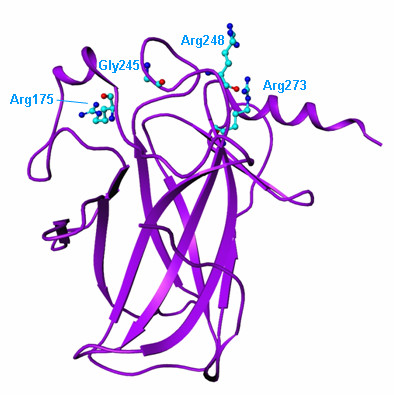
Ribbon representation of the human p53. Ribbon representation of the human p53 core domain X-ray structure (PDB Code: 2OCJ; Wang et al. (2007) [47]). Displayed in CPK representation are sites of major oncogenic mutations: Arg175, Gly245, Arg248 and Arg273.